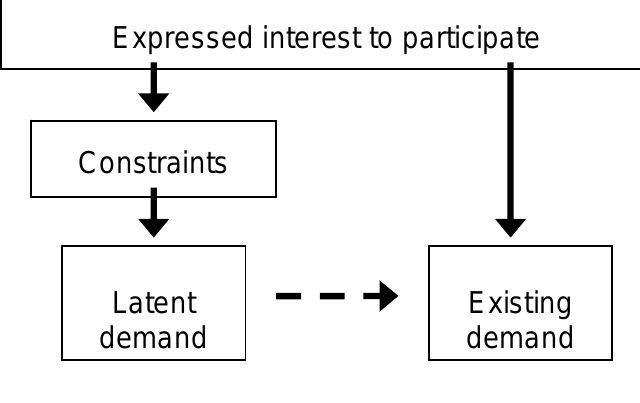
Figure 1. Relationships between expressed interest to participate, constraints, latent demand and existing